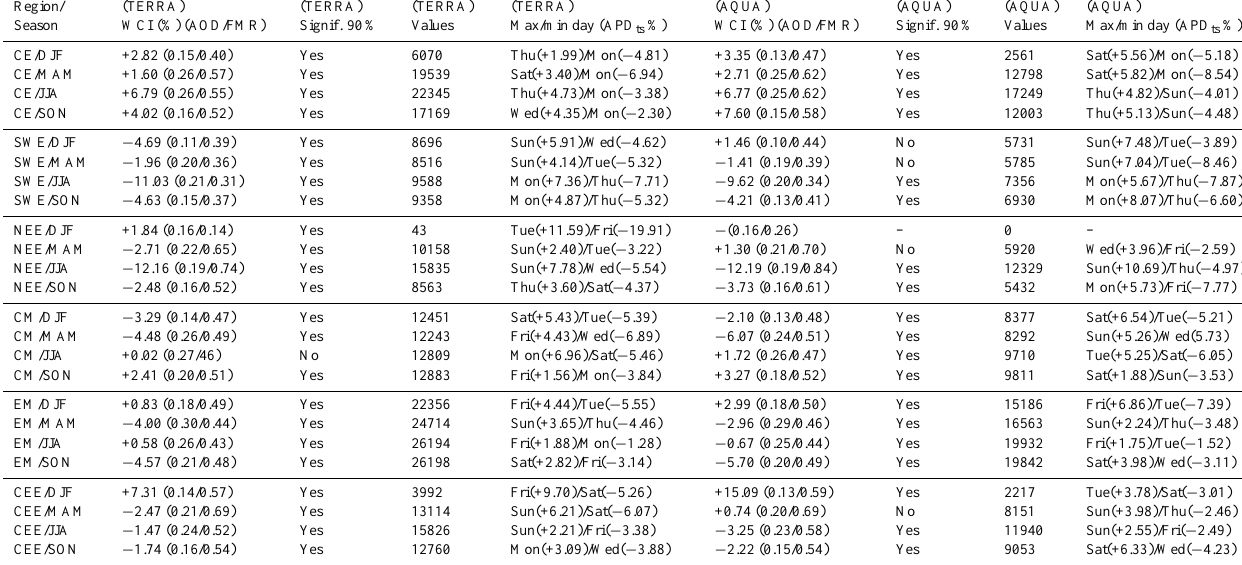
Table 3. Average seasonal WCI per region for the ± 1000% limit corrected dataset with the average AOD 550 and FMR 550 levels, seasonal day of maximum and minimum average percent departure from the weekly mean calculated from the region time series (APD ts ) and the corresponding APD ts values, statistical significance at the 90% confidence level and the number of values included in the calculations. Region/